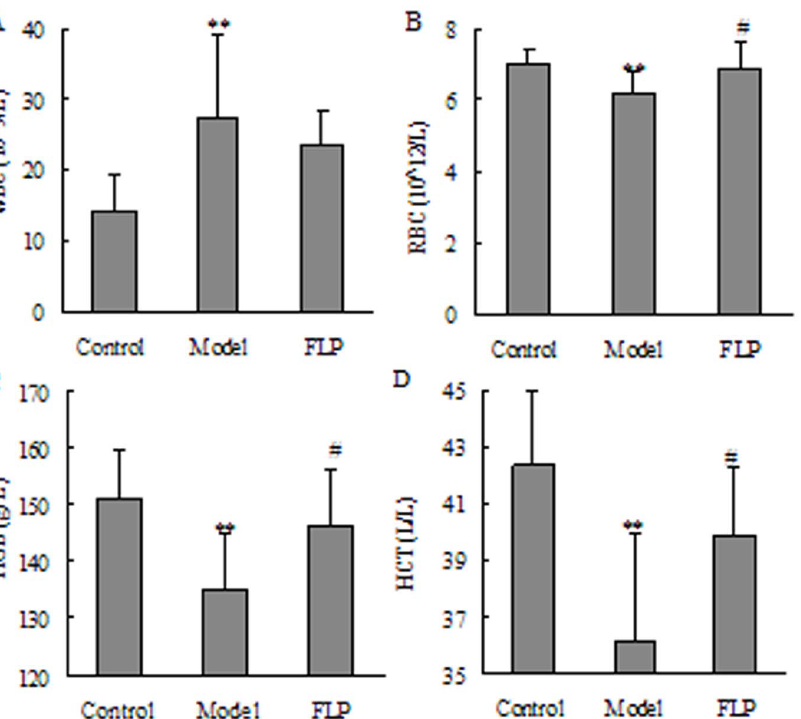
Figure 3. Basic blood routine parameters of the studied groups. (A) White blood cell count; (B) red blood cell; (C) hemoglobin and (D) hematocrit. The data were expressed as mean 6 SD. * P , 0.05, ** P , 0.01 compared to the control groups and # P , 0.05, ## P , 0.01 compared to the